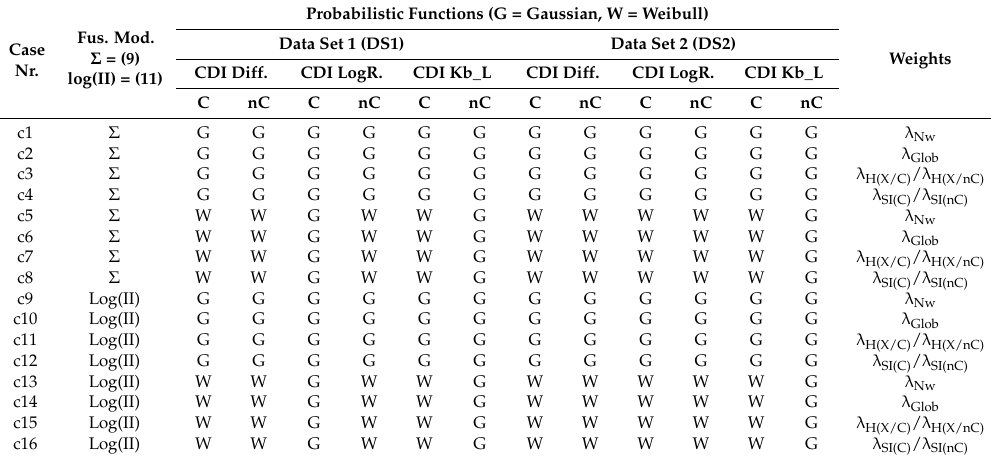
Table 7. Summary of the different considered